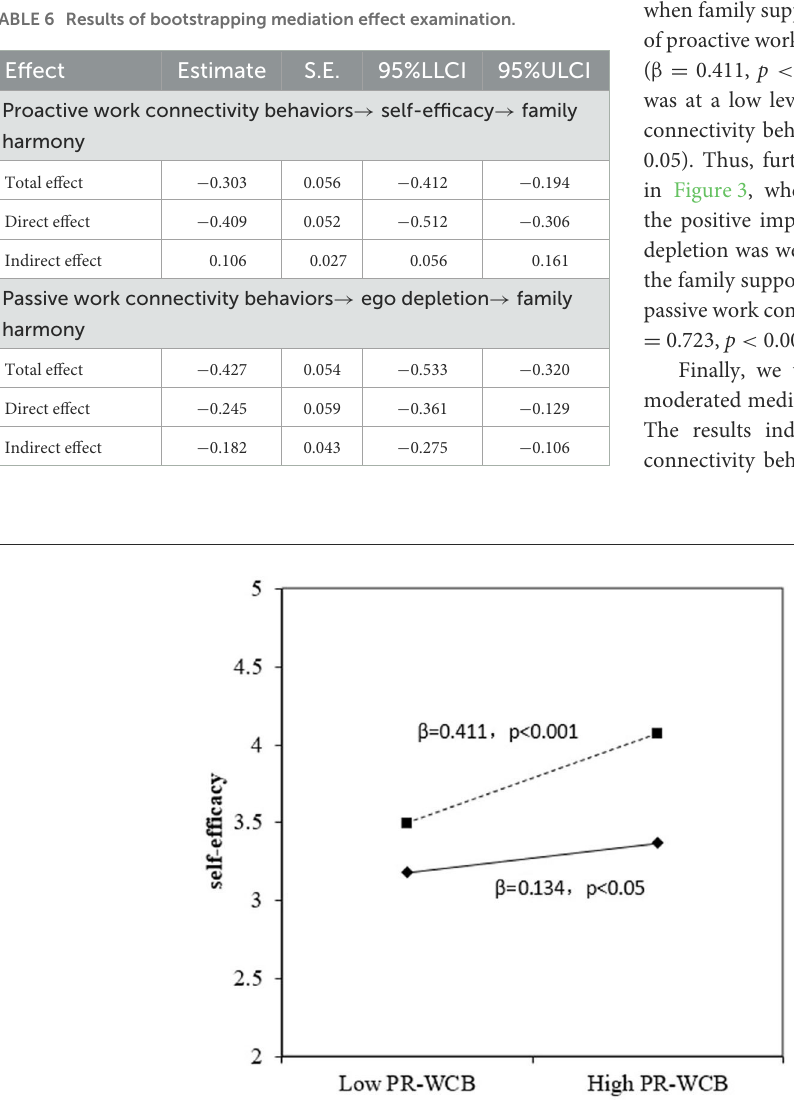
FIGURE2 The moderating effect of family support on the impact of PR-WCB on